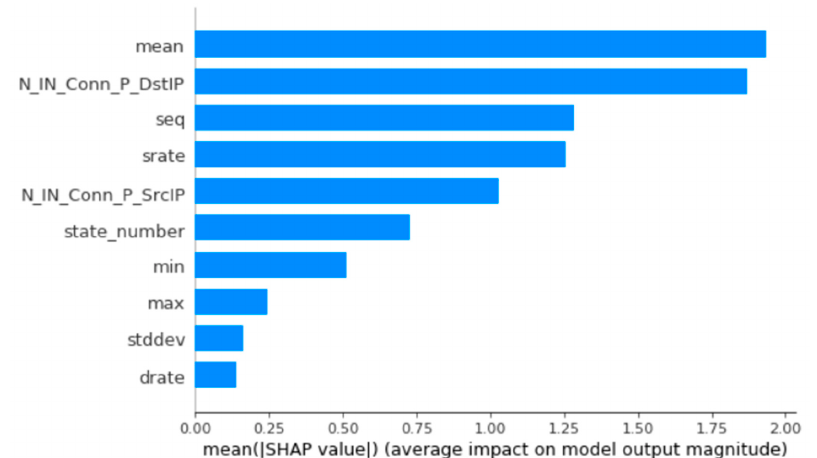
Figure 5. Average SHapley Additive exPlanation (SHAP) values.